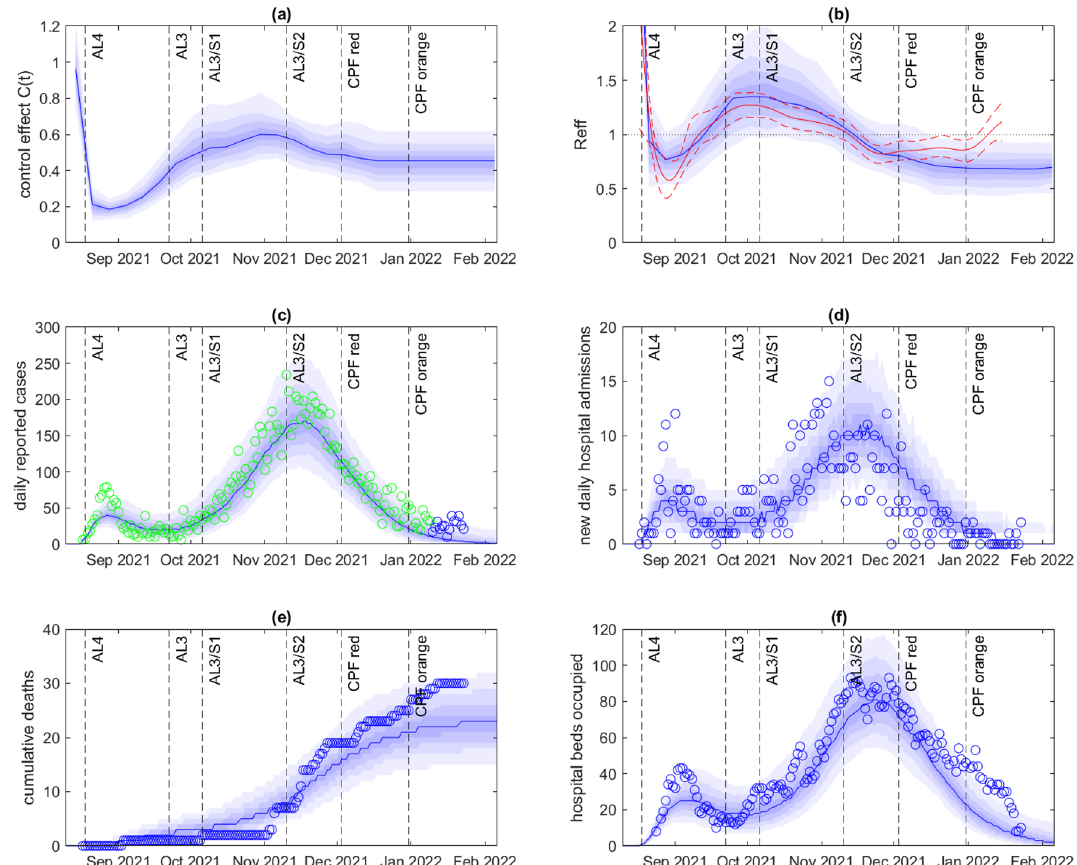
Figure 2. Model results fitted to data up to 9 January 2022. ( a ) Inferred control function C ( t ) ; ( b ) Effective reproduction number R eff ( t ) calculated in the model (blue) based on time-varying control function C ( t ) and vaccine-derived and infection-derived immunity, and independently estimated using the EpiNow2 package 23,45 (median estimate red solid, 90% credible band red dashed); ( c ) Daily reported cases; ( d ) New daily hospital admission; ( e ) Cumulative deaths; ( f ) Hospital beds occupied. In ( c ), green points show data that was used to fit the control function shown in ( a ). In ( a , b ), the blue curve shows the median and the shaded blue bands show the 10th, 20th, 30th, 40th, 60th, 70th, 80th, and 90th percentiles of the estimated posterior distribution for C ( t ) . In ( c – f ), the blue curve shows the median and the shaded blue bands show the 10th, 20th, 30th, 40th, 60th, 70th, 80th, and 90th percentiles of the specified model output across the best-fitting n = 500 out of 2500 model simulations, each with C ( t ) sampled independently from the estimated posterior. Dashed vertical lines show the times of key changes to public health restrictions for the Auckland region (see Table